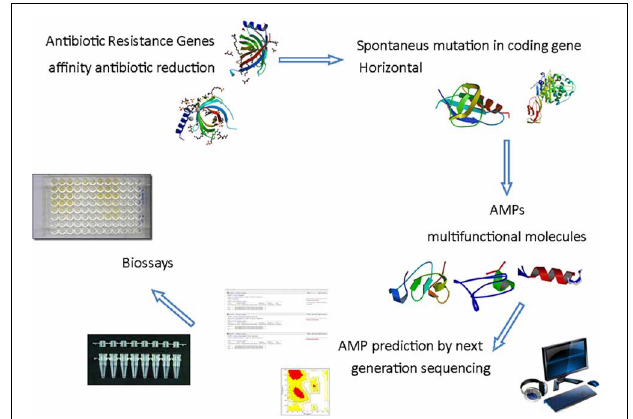
FIGURE 1 | Schematic antimicrobial peptides prospecting from the in silico analysis of sequences obtained by next generation sequencing. The demand for new antimicrobials to prevent microbial resistance from multifunctional action encourages the search for AMPs through prediction for next-generation sequencing followed by analysis of bioinformatics and computational modeling in order to produce effective peptides after antimicrobial trials. PDB IDs 3GP6; 1THQ; 2JSO; 3HUM; 2L24; 2KUS; 2LB7;